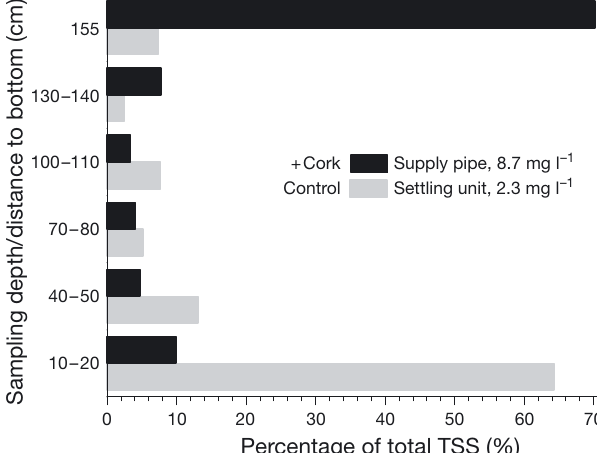
Fig. 7. Merged total suspended solids (TSS) concentration (left y-axis) and removal efficiency (right y-axis) of the drum Fig. 6. Vertical profile of total suspended solids (TSS) load filter (DF) (measured at sampling points SP7 and SP8, see for the 2 diets before removal (n = 238). The surface separa- Fig. 1) equipped with a 30 or 100 μm gauze. Values are tor was engaged during the cork trial; the settling basin means ± SE. For significant differences, see operated during the control trial